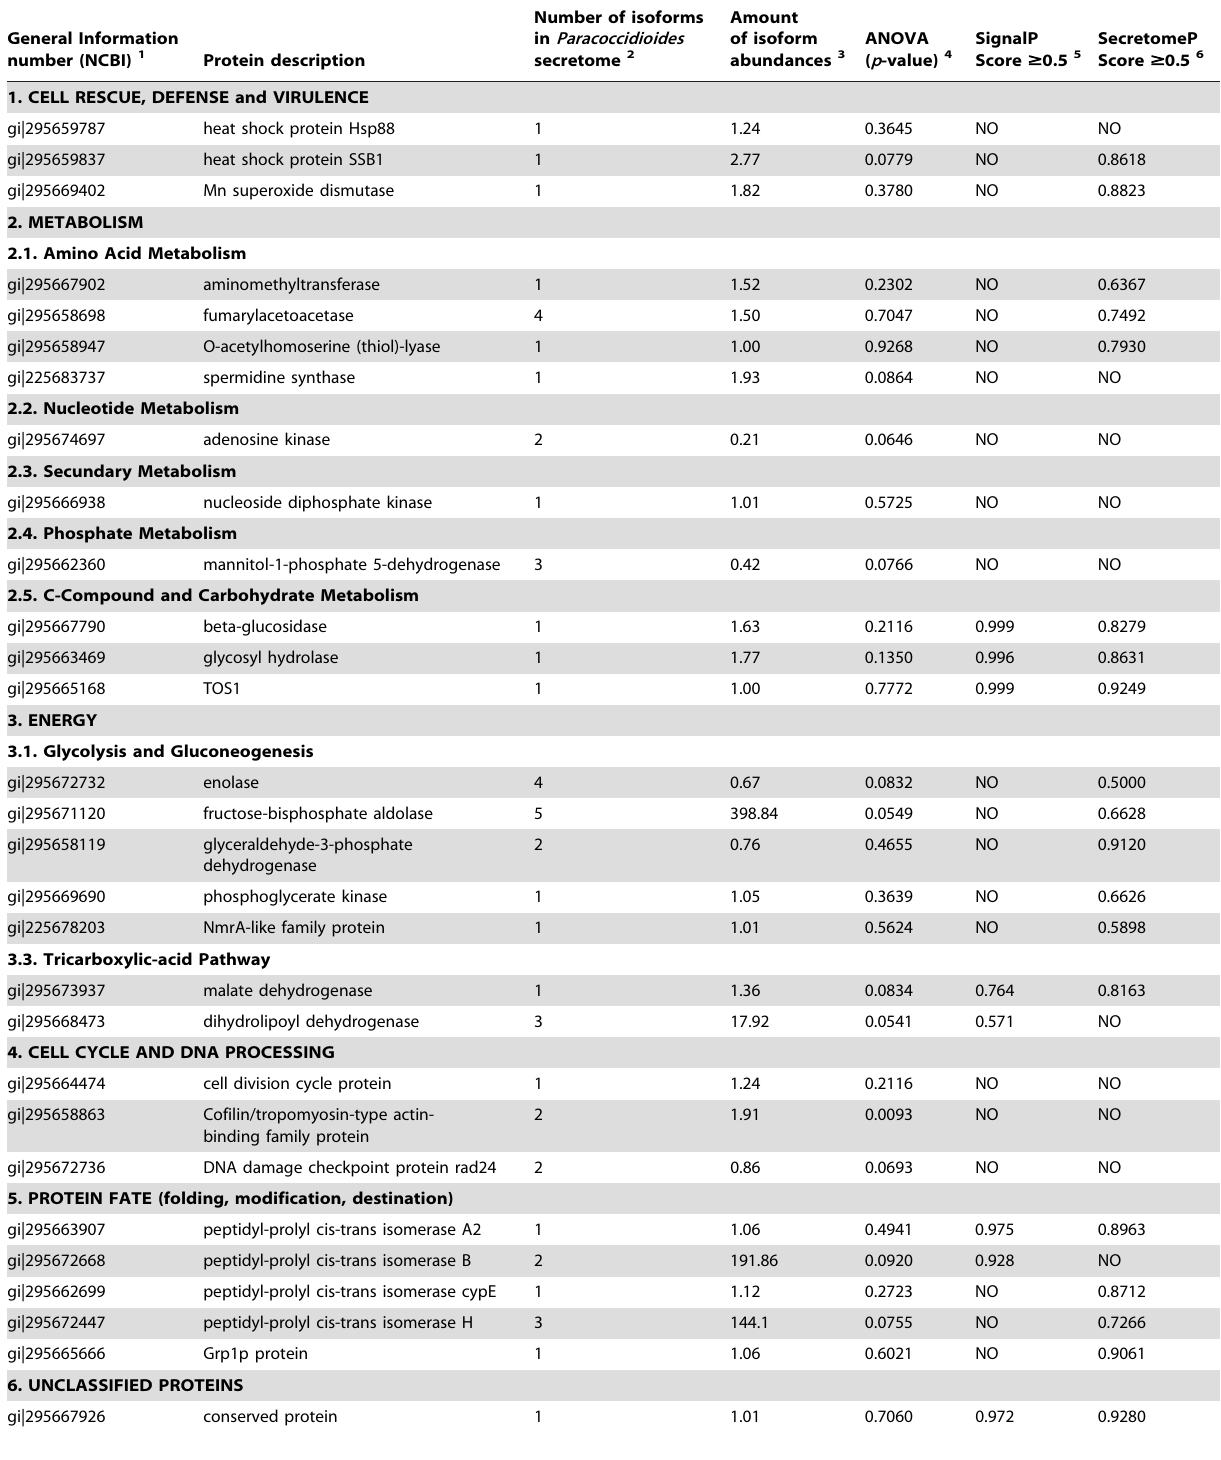
Table 1. Constitutive proteins secreted by Paracoccidioides Pb 01 yeast and mycelia.